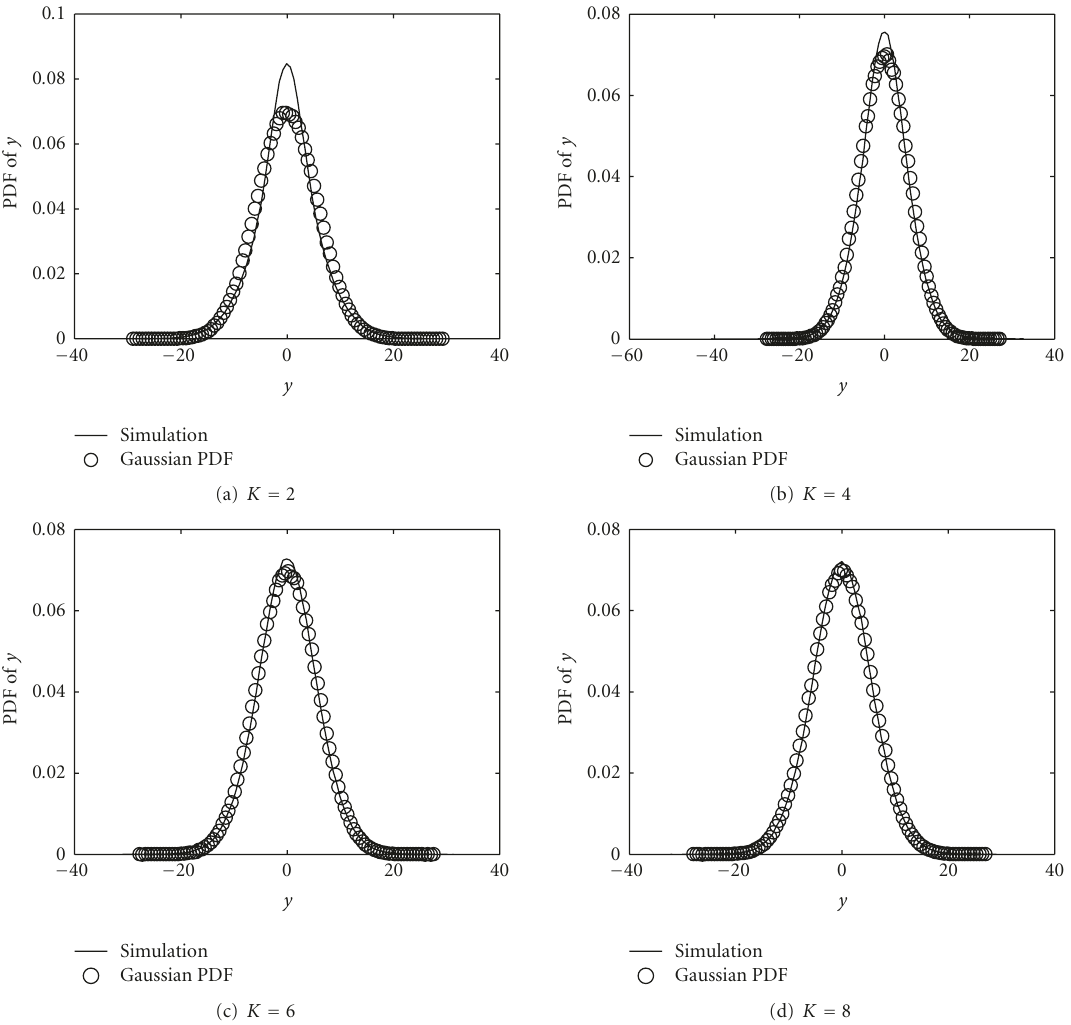
Figure 4: Comparison of the actual (or simulated) and Gaussian distributions for 4-PAM at SNR of 10 dB with various K .